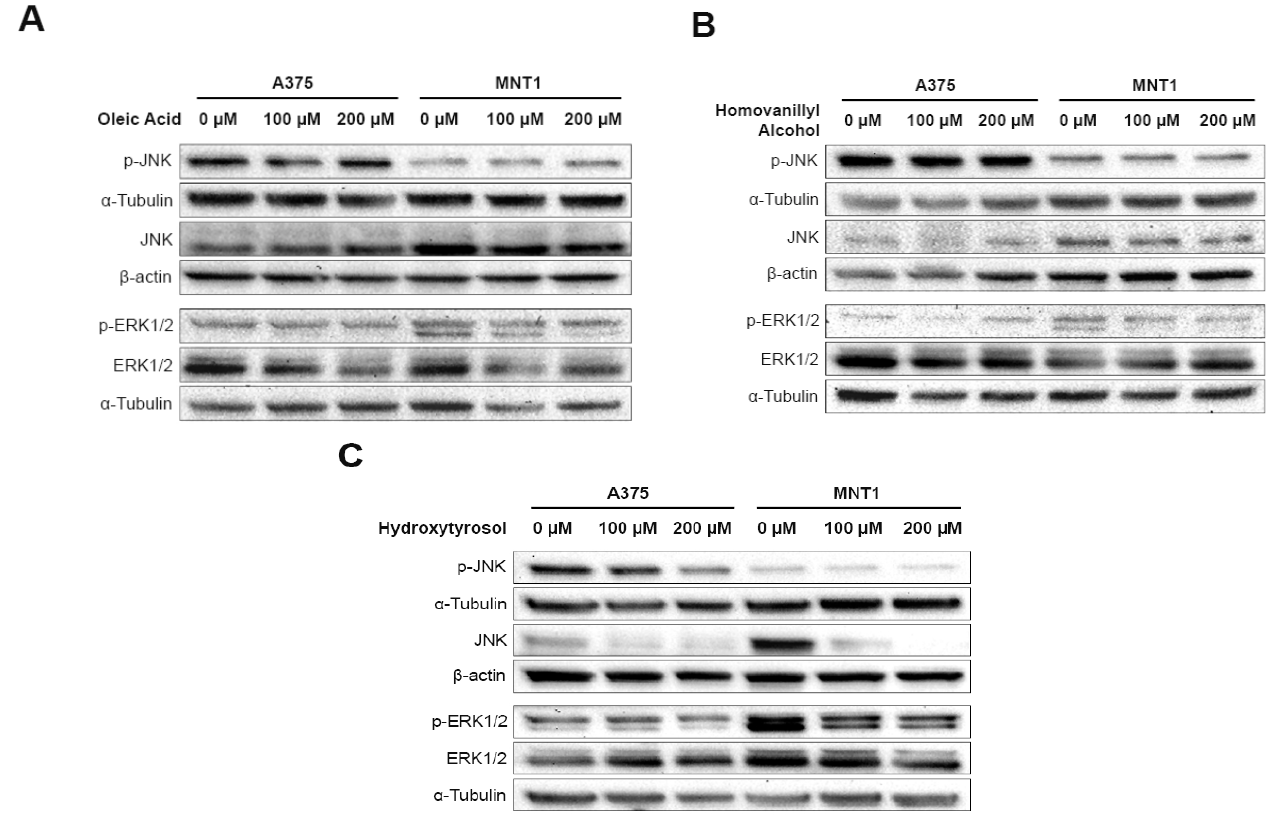
Figure 3. Impact of ( A ) oleic acid, ( B ) homovanillyl alcohol, and ( C ) hydroxytyrosol at concentrations of 100 µM and 200 µM on ERK and JNK pathway activation in A375 and MNT1 cells. Protein expression was detected by Western blot after 48 h of exposure to the three olive oil compounds.